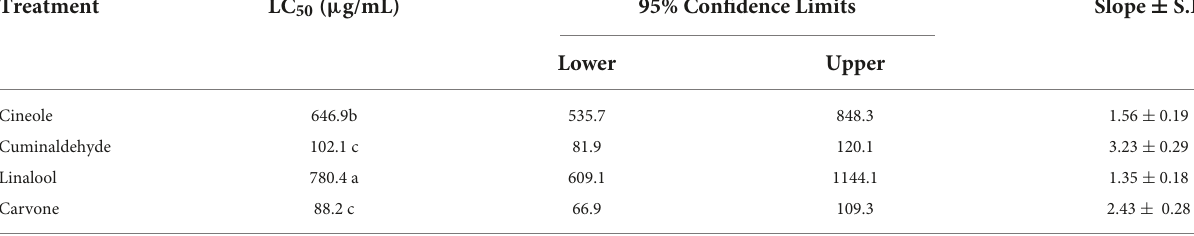
TABLE 3 Effect of the used compounds on the hatching.